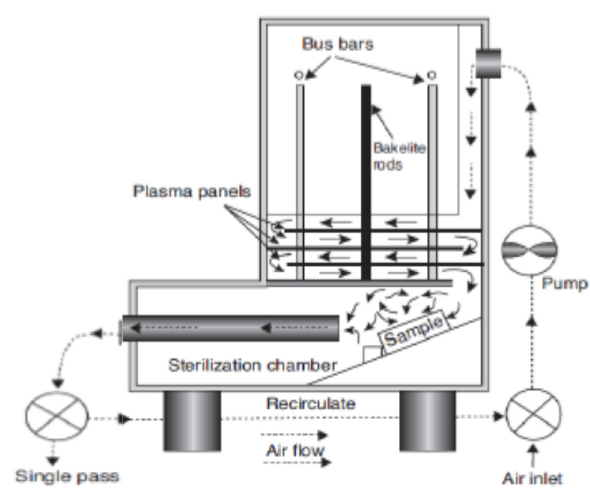
Figure 2. Remote exposure plasma generator [22] .